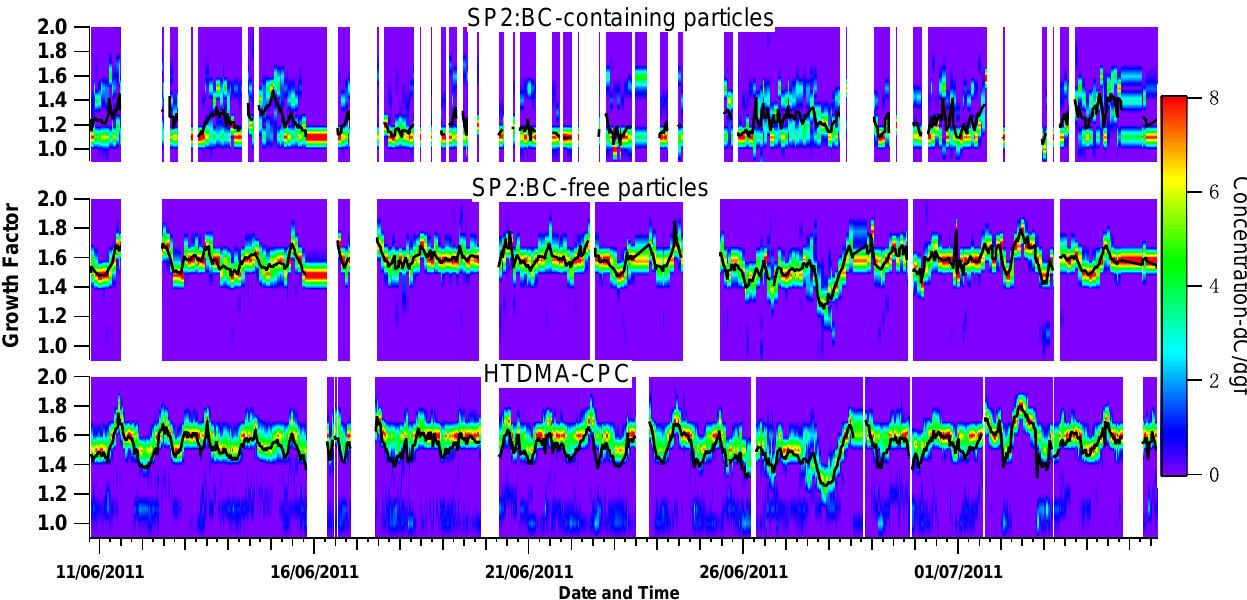
Fig. 5. The inverted gf distribution at D mob = 163nm for HTDMA CPC, HTDMA-SP2 measured BC-containing and BC-free particles. The black lines in each panel show the averaged gf for each complete HTDMA scan.